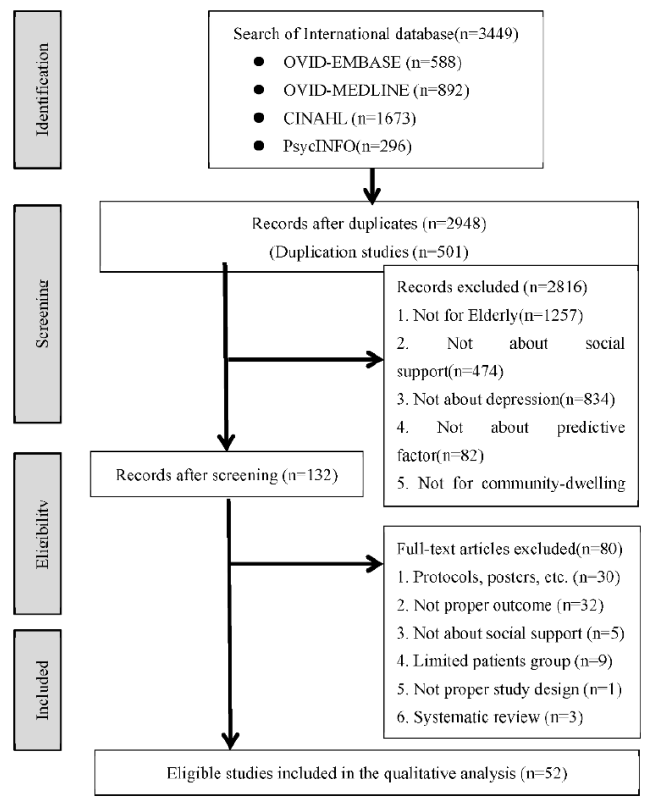
Figure 1. Flow chart.